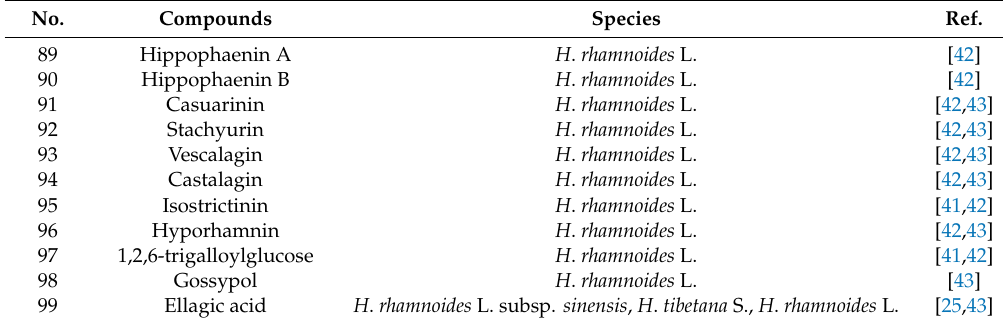
Table 4. Others from Hippophae species.